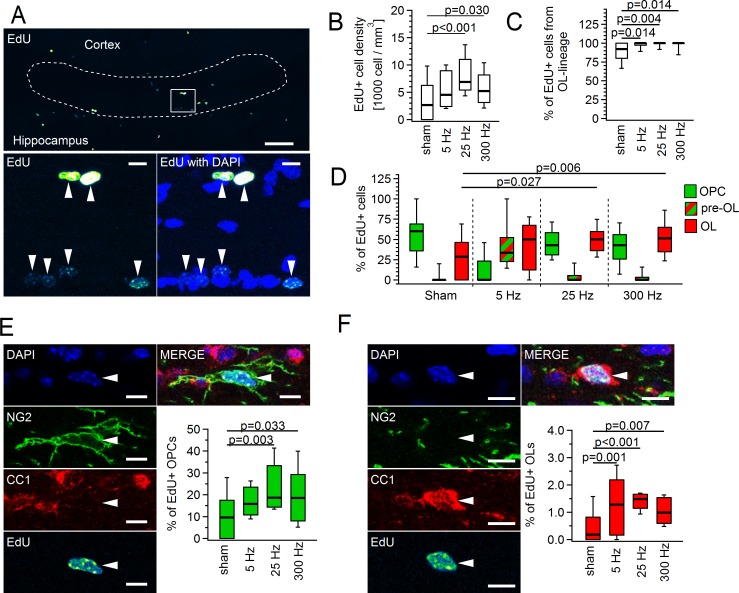
Callosal stimulation in vivo enhances proliferation rate of oligodendrocyte precursor cells (OPCs) and promotes differentiation of newly born OPCs into oligodendrocytes (OLs).(A) Coronal sections of corpus callosum. Maximum intensity projection image (from 14 successive confocal planes) showing fluorescent 5-ethynyl-2´-deoxyuridine (EdU) labelling in corpus callosum. White dashed line marks the region of interest used for cell counting. Top panel: overview. Scale bar: 100 μm. Bottom panels: higher magnification of the area marked by the white square at the top panel; left, EdU (false color look-up table (LUT) “Green Fire Blue”); right, overlay of EdU and DAPI (blue) channels. Arrowheads indicate EdU+ cells. Scale bar: 10 μm. (B) Density of EdU+ cells in corpus callosum. (C) Proportion of OL lineage cells (OPCs + pre-OLs + OLs) labelled with EdU, within the total population of EdU+ cells. (D) Proportion of EdU+ OPCs (green), premyelinating OLs (pre-OLs) (red-green) and OLs (red) within the total population of EdU+ cells. (E) Single layer confocal image showing quadruple channel fluorescent labelling with DAPI (blue), NG2 (green), CC1 (red), and EdU (false color LUT “Green Fire Blue”), and the overlay of four channels (top right). The arrowhead indicates an EdU+ OPC. Scale bars: 10 μm. The box plot shows proportion of EdU+ OPCs within the total OPCs population. (F) Single layer confocal image showing quadruple-channel fluorescent labelling with DAPI (blue), NG2 (green), CC1 (red), and EdU (false color LUT “Green Fire Blue”), and the overlay of four channels (top right). The arrowhead points to an EdU+ OL. Scale bar: 10 μm. The box plot shows proportion of EdU+ OLs within the total OLs population. Throughout this figure, the same mice and slices were analyzed as in Fig 7. Nested ANOVA and post hoc Tukey test were used for statistical analysis (S15 Data). Box and whisker plots: the bottom and top of each box represent 25th and 75th percentiles of the data, respectively, while whiskers represent 10th and 90th percentiles. The midline represents the median. The numerical data used in B–F are included in S14 Data.